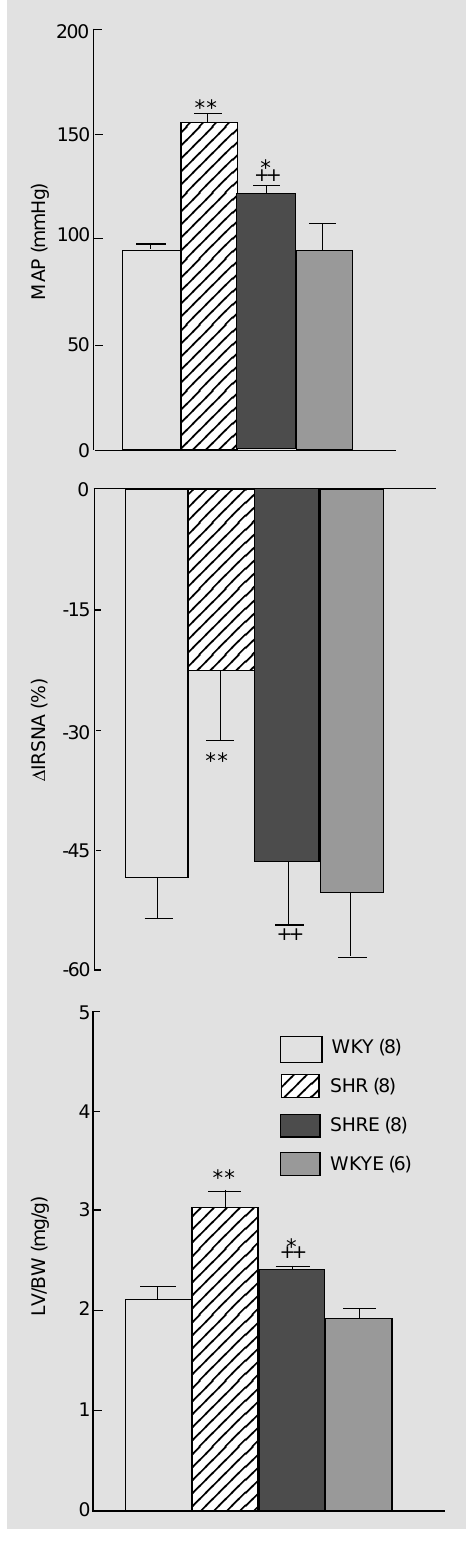
Figure 1 - Effects of enalapril (E) treatment on mean arterial pres- sure (MAP) (top panel), change in integrated renal sympathetic nerve activity (IRSNA, expressed as % inhibition) produced by an acute isotonic saline load (mid- dle panel), and left ventricular weight/body weight ratio (LV/ BW; bottom panel) in SHR and WKY rats. Values are reported as mean ± SEM. *P<0.05 and **P<0.01 compared to WKY (ANOVA followed by Fisher test). ++ P<0.01 compared to SHR (ANOVA followed by Fisher